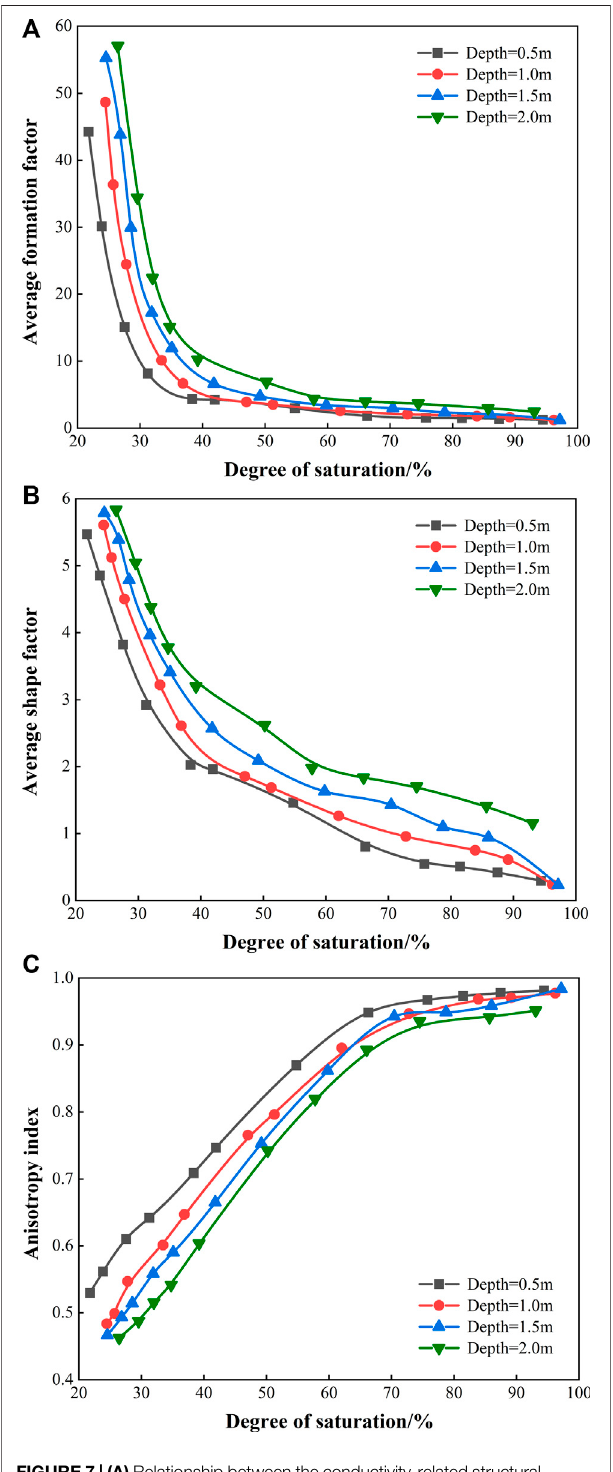
FIGURE 7 | (A) Relationship between the conductivity-related structural parameters and soil saturation. (B) Relationship between average shape factor and degree of saturation. (C) Relationship between anisotropy index and degree of saturation.